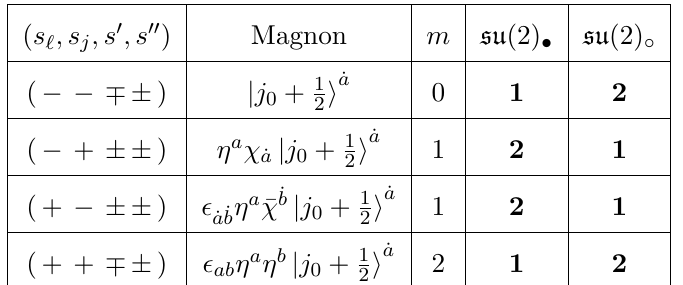
Table 4 . Level N e(cid:11) = 0 states in the chiral R sector of the WZW model and their spin-chain counterparts, which have momentum p = 0. In the WZW model they are identi(cid:12)ed by the labels ( s ‘ ; s j ; s 0 ; s 00 ), where s ‘ keeps track of sl (2) fermionic zero-modes, s j of su (2) ones and s 0 ; s 00 are related to the T 4 directions. As discussed in appendix D, they take values (cid:6) 1 = 2 and (cid:14) = s ‘ + s j +1, which indeed matches the m = (cid:22) charge of the corresponding spin-chain excitation. We also indicate the relevant su (2) (cid:15) (cid:8) su (2) (cid:14) representations.